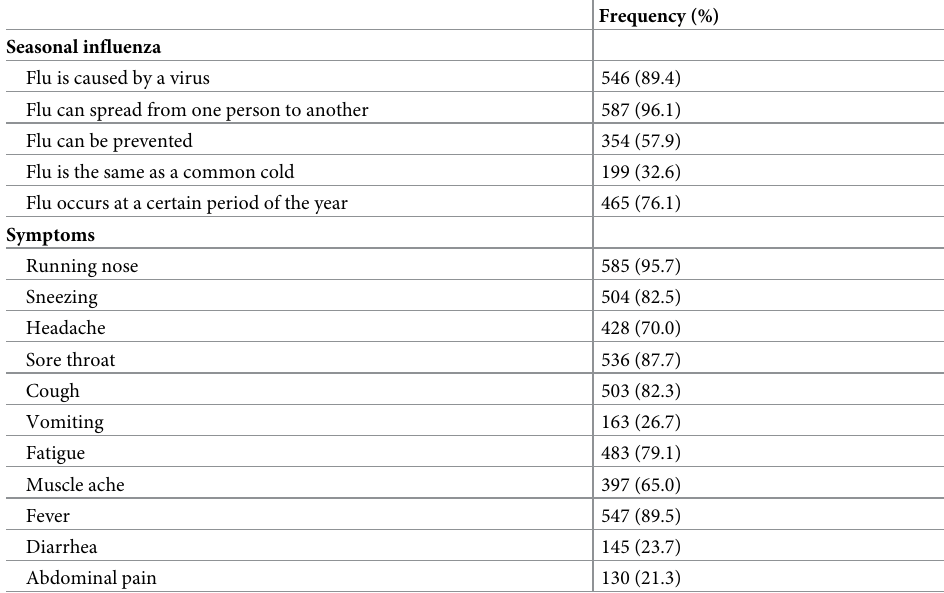
Table 2. Participants’ knowledge regarding seasonal influenza (N =